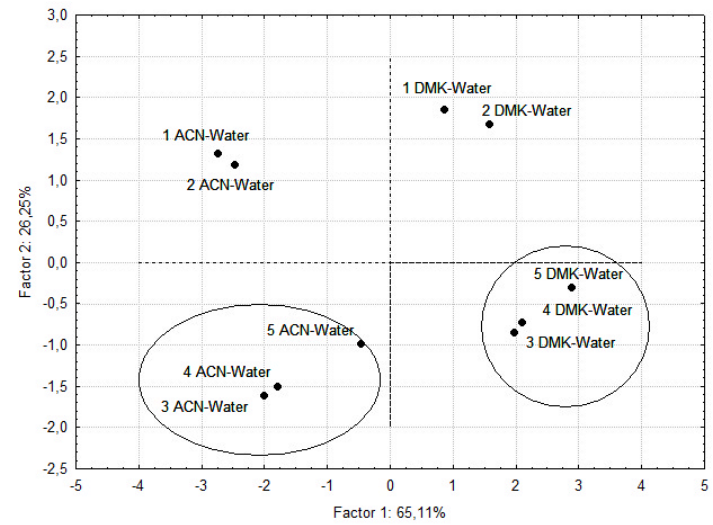
Figure 2. Principal component analysis 1 shows structure-retention relationships of studied steroids. The numbers on the graph correspond to the hormone respectively: 1 – cortisone, 2 – hydrocortisone, 3 – methylprednisolone, 4 – prednisone and 5 – norgestrel. Data incorporated into the matrix consisted of retention data (R ) of the studied steroids using silica gel adsorbent as a stationary phase M and a mixture of acetonitrile-water and acetone-water in a wide range of concentrations (20-80% v/v) as the mobile phase. The matrix consists of 10 cases and 7 variables.